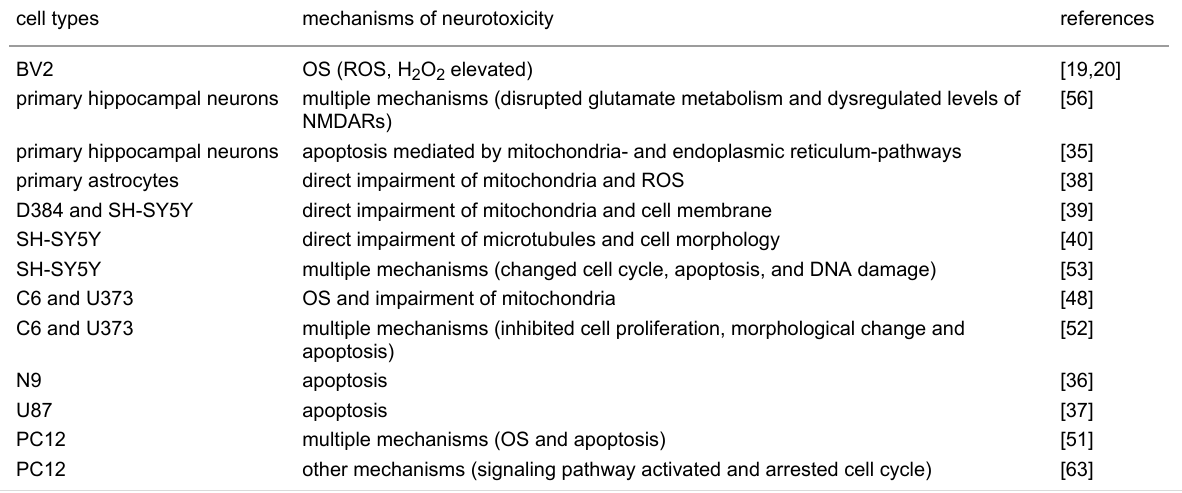
Table 2: Main mechanisms of neurotoxicity of titanium dioxide nanoparticles in in vitro studies. cell types